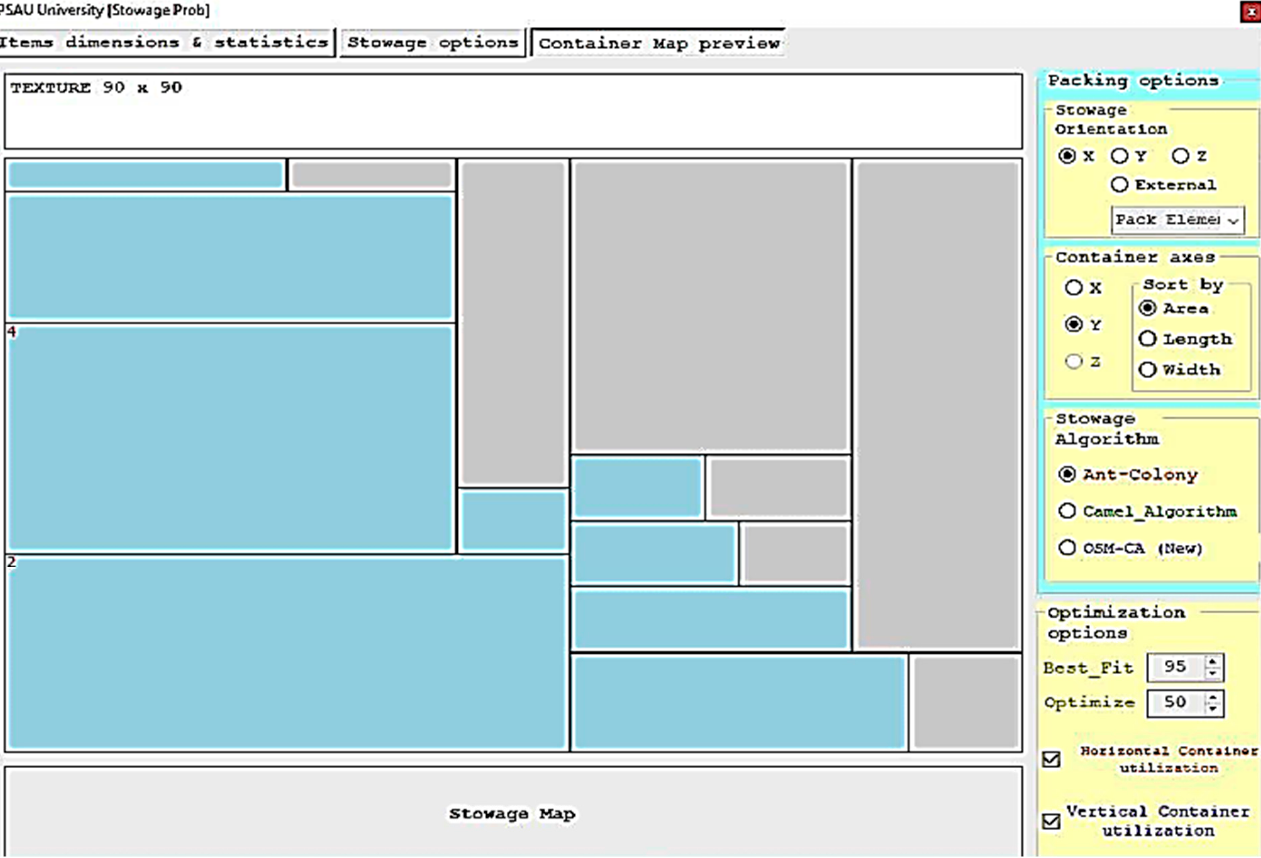
Figure A5. The stowage map for seven objects by the camel algorithm optimization for first station on the distribution path.